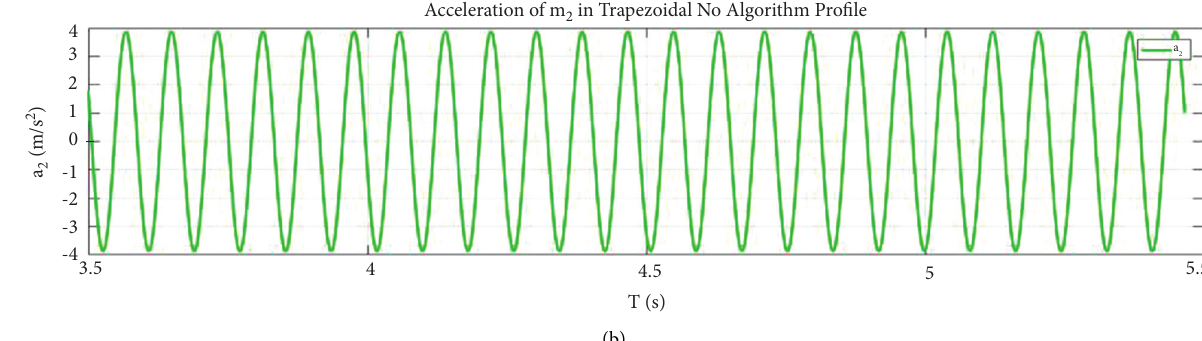
st term, orange: 2 nd